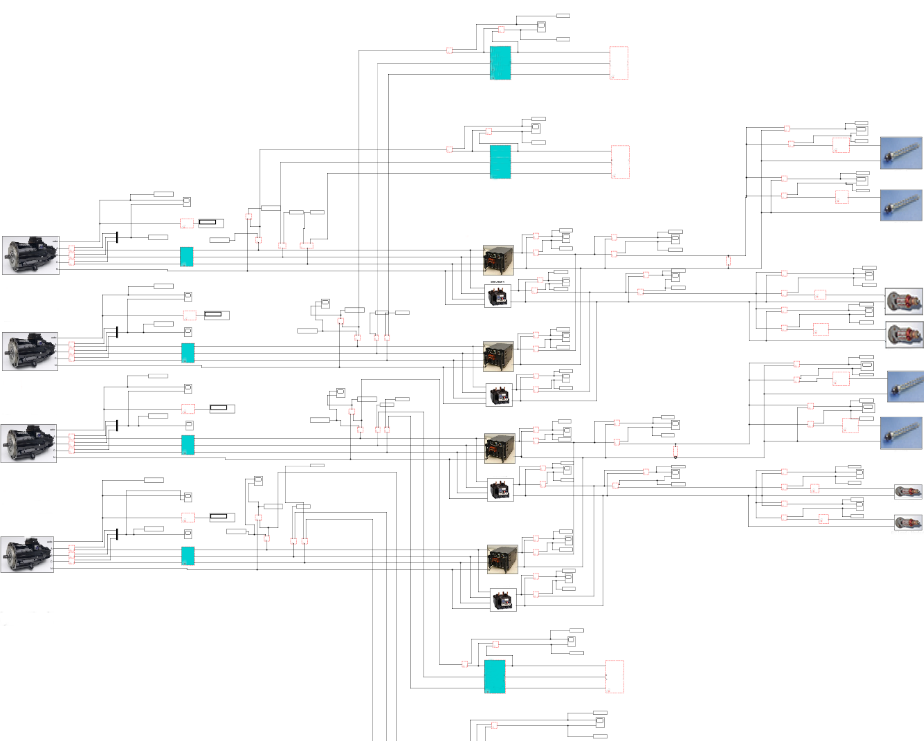
Figure 6. Power supply system simulation model.